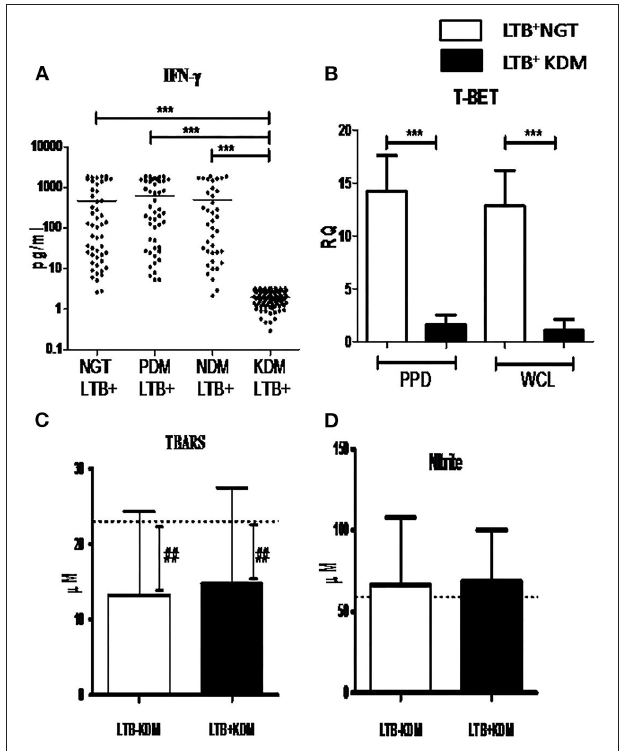
FIGURE 7 | Chronic diabetes decreases the secretion of IFN- γ and expression of T-bet in LTB + subjects. The levels of IFN- γ in the quantiferon supernatant in LTB + NGT ( n = 50), LTB + PDM ( n = 47), LTB + NDM ( n = 39) and LTB + KDM ( n = 76) subjects was quantified by ELISA (A) . The expression of T-bet in whole blood cultures stimulated with mycobacterial antigens (PPD and WCL) in LTB + NGT ( n = 30) and LTB + KDM ( n = 30) subjects w–as quantified by qRT-PCR (B) . The circulating levels of TBARS (C) and nitrite (D) in LTB-KDM ( n = 93) and LTB + KDM ( n = 82) subjects were quantified by colorimetry. The basal level, as was seen in LTB-NGT, is shown as dashed line (—-), as reference. Statistical significance was determined by non-parametric Mann–Whitney U -test and p < 0.05 was considered significant. * p < 0.05; ** p < 0.01 for LTB-KDM vs. LTB + KDM; ## p < 0.01 for LTB-NGT vs.